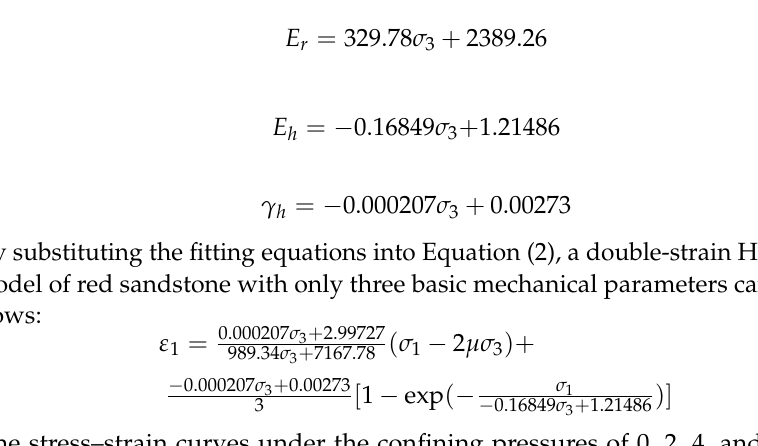
Figure 11. Relationship between model parameters and con fi ning pressure.